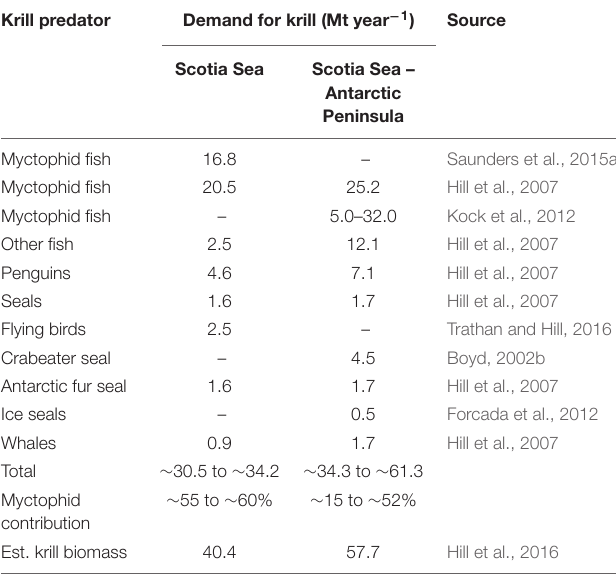
TABLE 7 | Summary of the current estimates of annual consumption of krill (million tonnes per year) in the Scotia Sea region by the main krill predators, showing the % contribution of myctophids to the